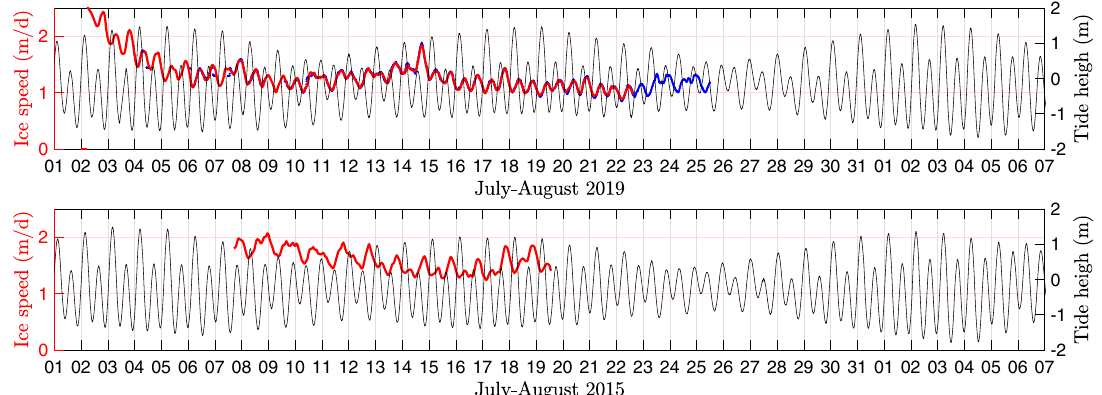
Fig. 4 Tidal and ice-speed data. Tide-gauge records of 2019 and 2015 from Pituf fi k/Thule versus the ice speed measured near the calving front of Bowdoin Glacier (GPS B1501 and GPS B1901/#9; the latter is shown in